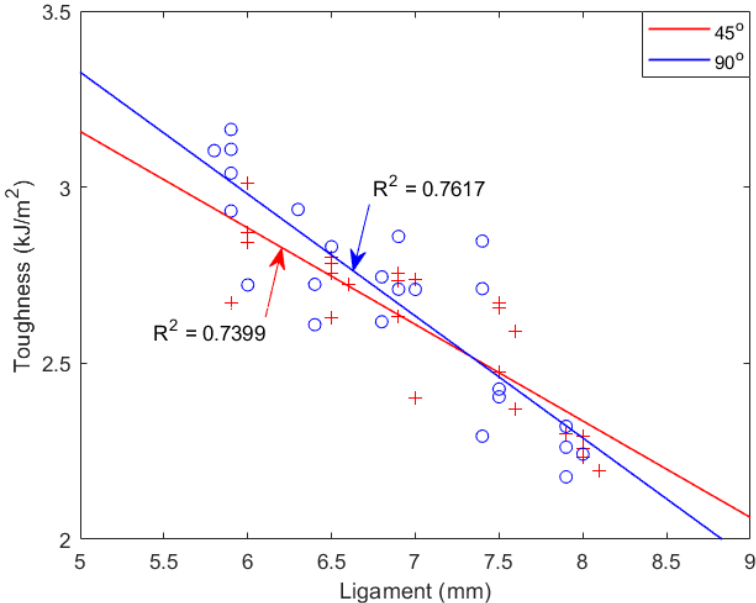
Figure 5. Charpy impact toughness with various ligaments. ‘o’ represents Izod toughness with notch angle of 90°; ‘+’ represents Izod toughness with notch angle of 45°.